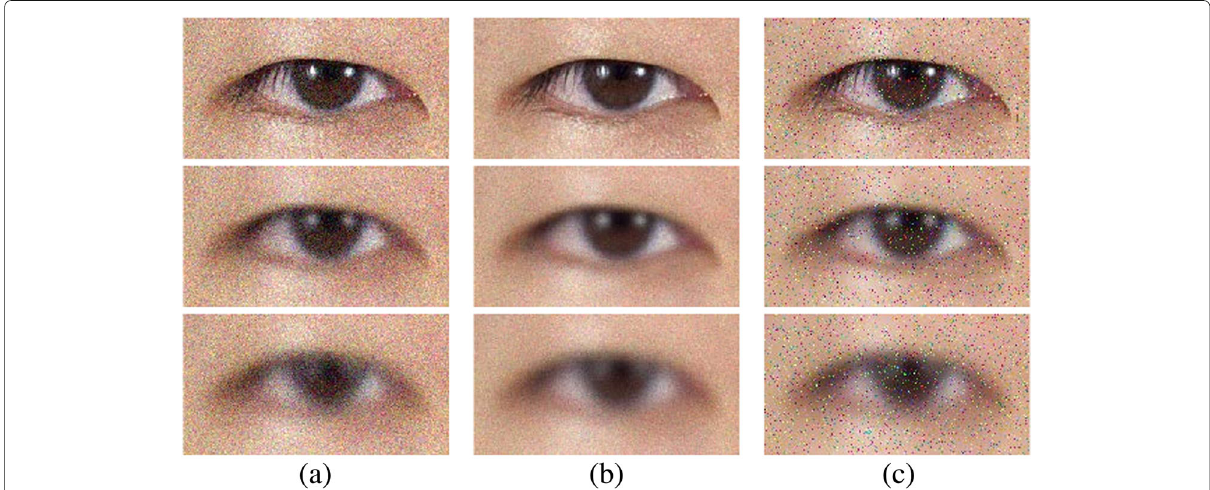
Fig. 10 Some examples of images with added noise. Gaussian noise ( a ), Poisson noise ( b ) and salt & pepper noise ( c ). Rows are for Gaussian blur of sigma = 0, sigma = 3 and sigma = 6